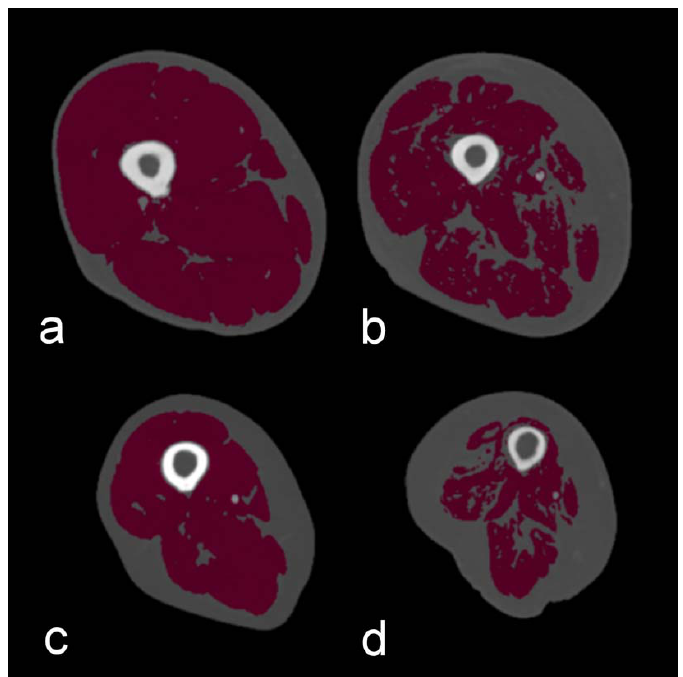
Figure 2. Cross-sectional skeletal muscle measurements of the lower extremity at 60% of the length of the femur, as seen from the knee. ( a ) No muscle atrophy and non-myosteatotic and ( b ) No muscle atrophy, but myosteatotic ( c ) Muscle atrophy, but non-myosteatotic. ( d ) Muscle atrophy and my- osteatotic.